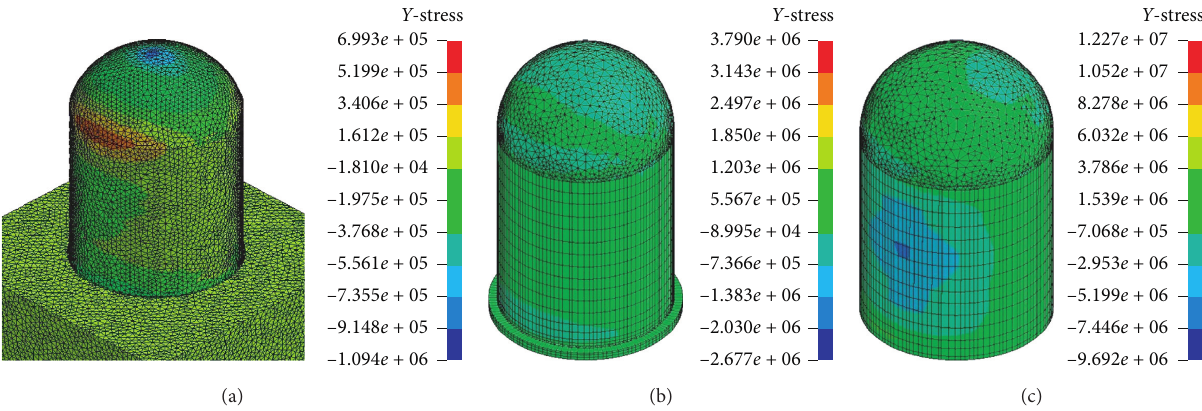
Figure 15: Comparison of the Y -stress response of SSIS-NC (a), CAMSBID-NC (b), and FB-NC (c) models under the effect of the 2011 Tohoku